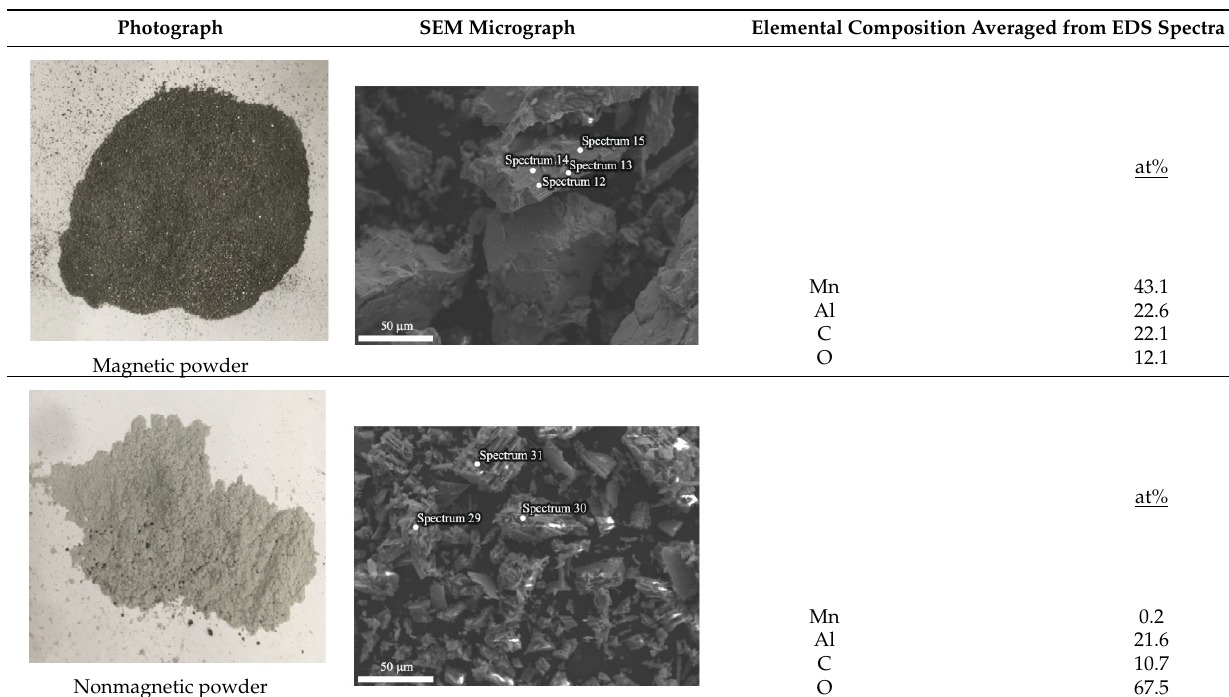
Table 1. Comparison between magnetic and nonmagnetic powders separated by magnetic field. MnAl–C0 was annealed at 550 °C for 20 min under argon atmosphere.